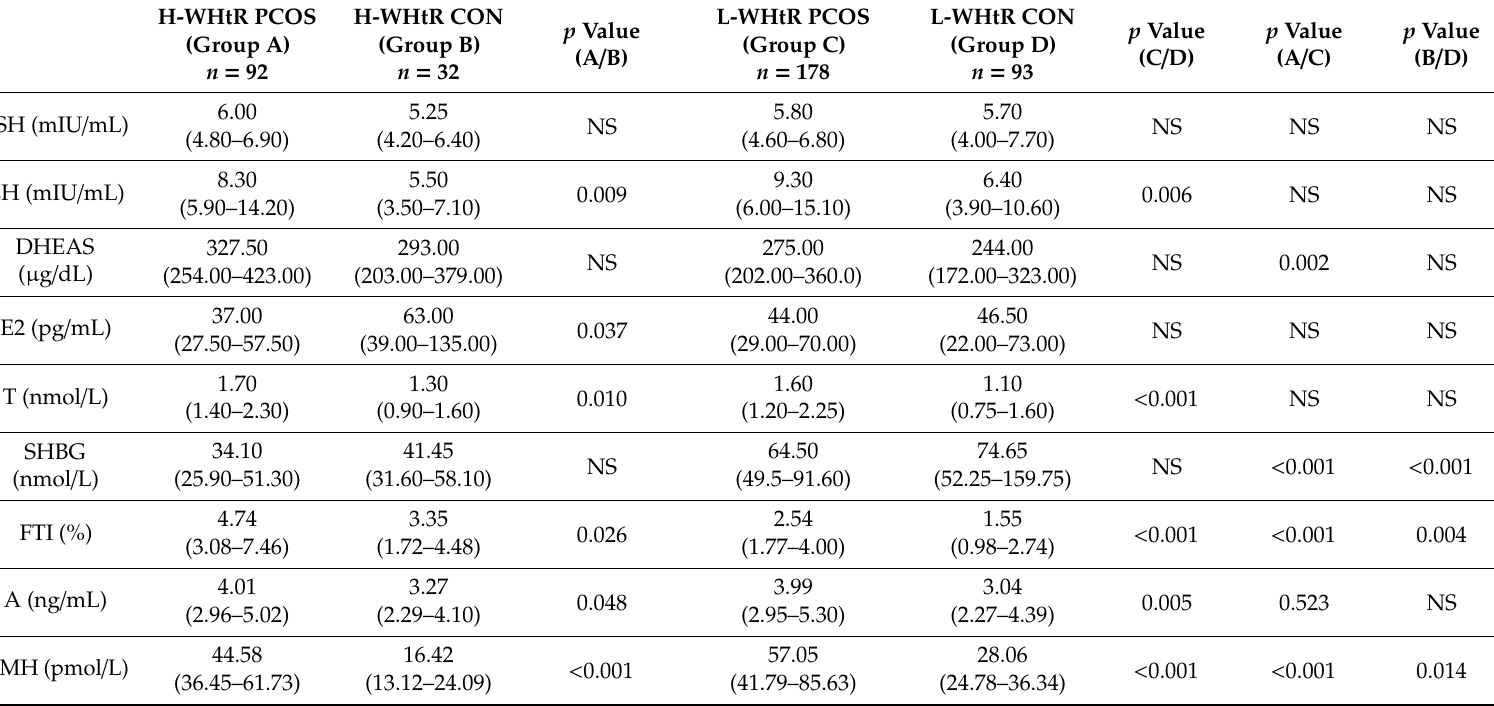
Table 3. Hormonal parameters in the PCOS and CON